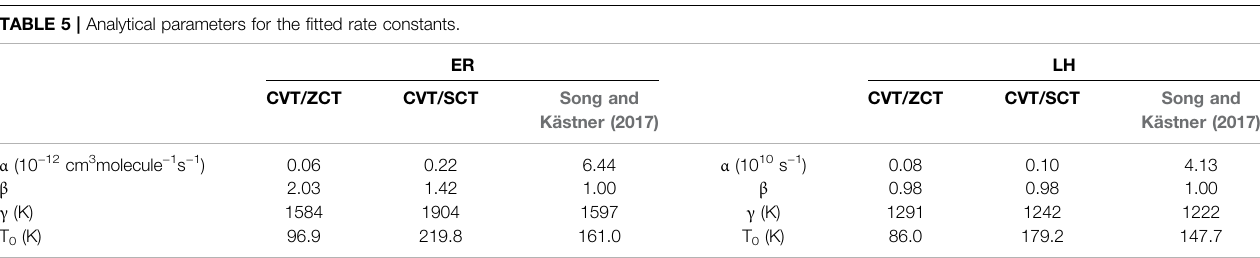
TABLE 5 | Analytical parameters for the fi tted rate constants.